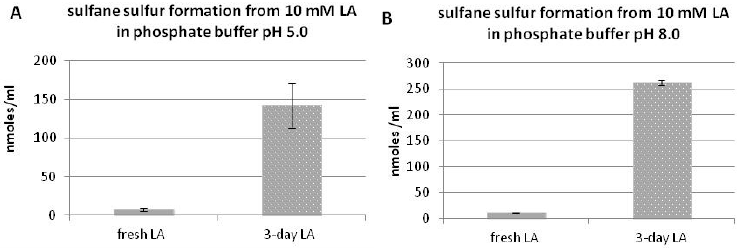
Figure 2. Level of sulfane sulfur formed in vitro from fresh LA or from LA left for three days unprotected from light at pH 5.0 ( A ) or 8.0 ( B ). The results are presented as the means ± SD.